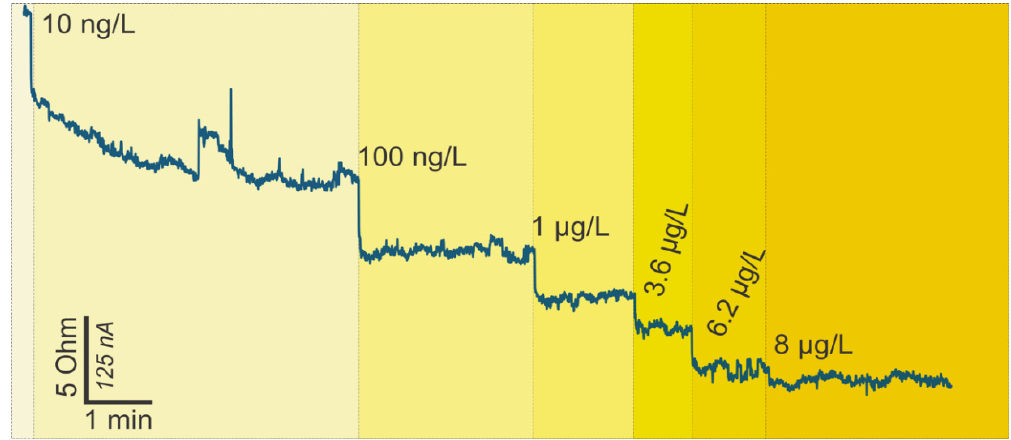
Figure 3. Change in resistance versus time readings for the GFET ferritin biosensor on the addition of ferritin-free buffer (phosphate-buffered saline (PBS)) and increasing ferritin concentration.